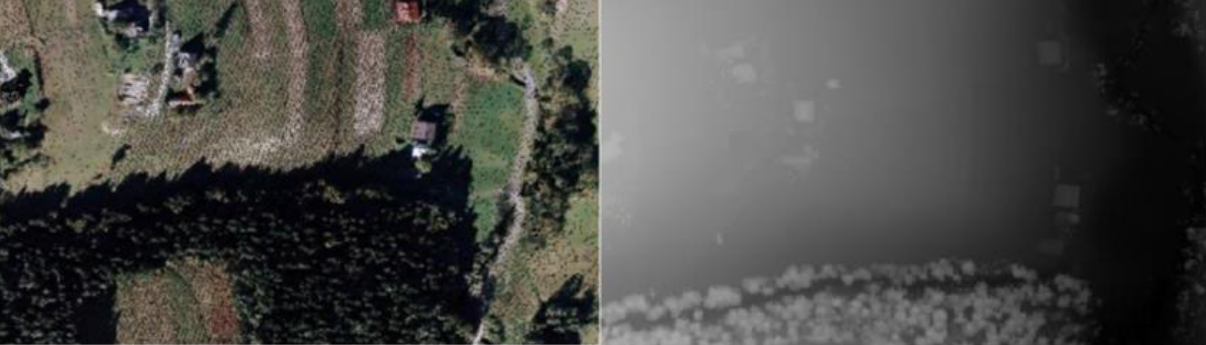
Figure 13. The cloud of points from the fragment of Kamionka Wielka (on the left ), along with the corresponding digital surface model ( right ) .